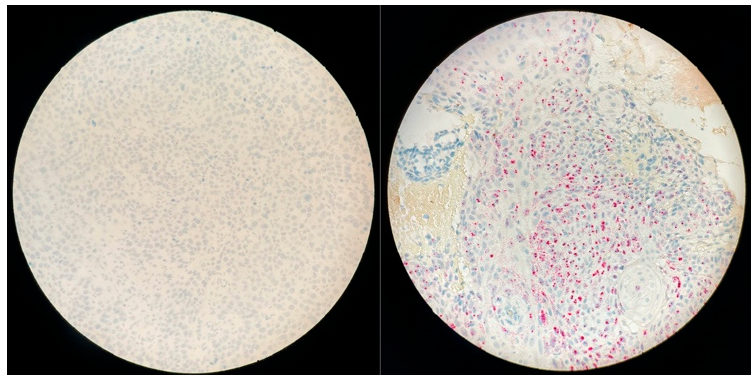
Figure 3. HPV RNAscope: negative ( left ); positive ( right ).